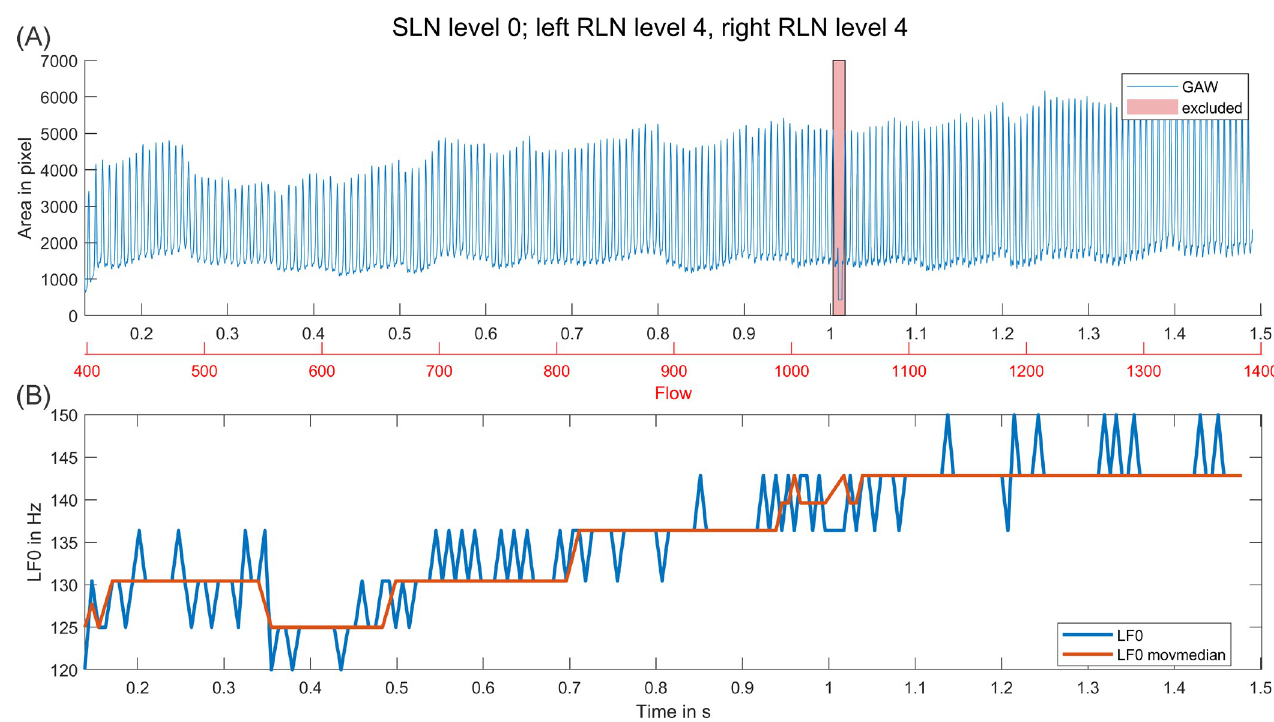
Fig 3. Example for small LF0 increase over time for no SLN stimulation. (A) GAW over period of stimulation with increasing flow, excluded section due to camera malfunction is marked. (B) LF0 and median LF0 (10 cycles) over same